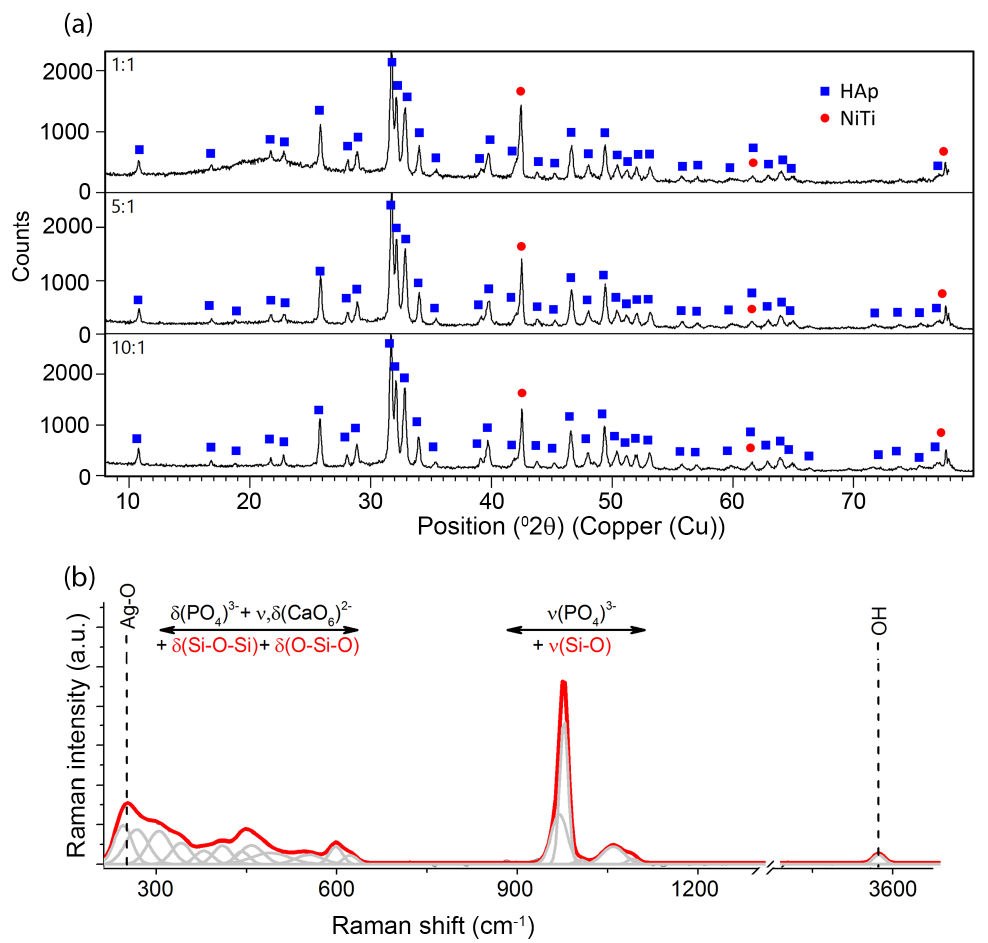
Figure 3. XRD patterns collected for hybrid coatings with different HAp: nSiO 2 /Ag ratios deposited under following parameters: 1:1 50 V/240 s, 5:1 50 V/120 s, and 10:1 40 V/90 s ( a ). Exemplary Raman spectrum of a coating composed of the co-deposited HAp/nSiO 2 /Ag on the NiTi surface. The bands were fitted using Voigt function with the minimum number of components ( b ).